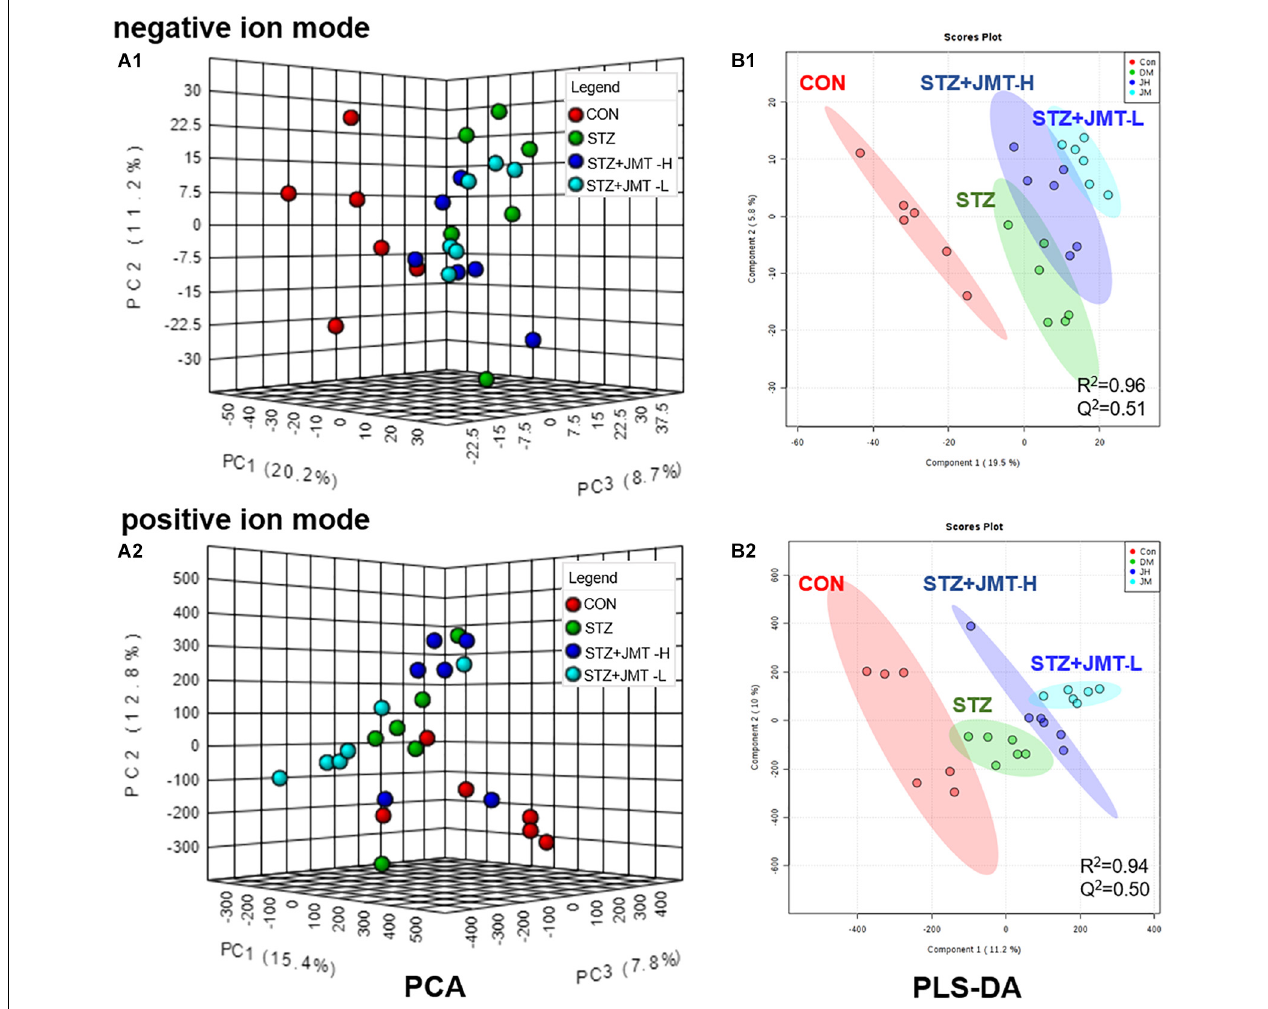
FIGURE 4 | Discrimination of the serum metabolic profile among Control (CON), STZ, STZ + JMT-H, STZ + JMT-L rats. (A1,A2) The score plots of PCA in negative and positive ion modes, respectively. (B1,B2) The score plots of PLS-DA in negative and positive ion modes, respectively, n = 6 per